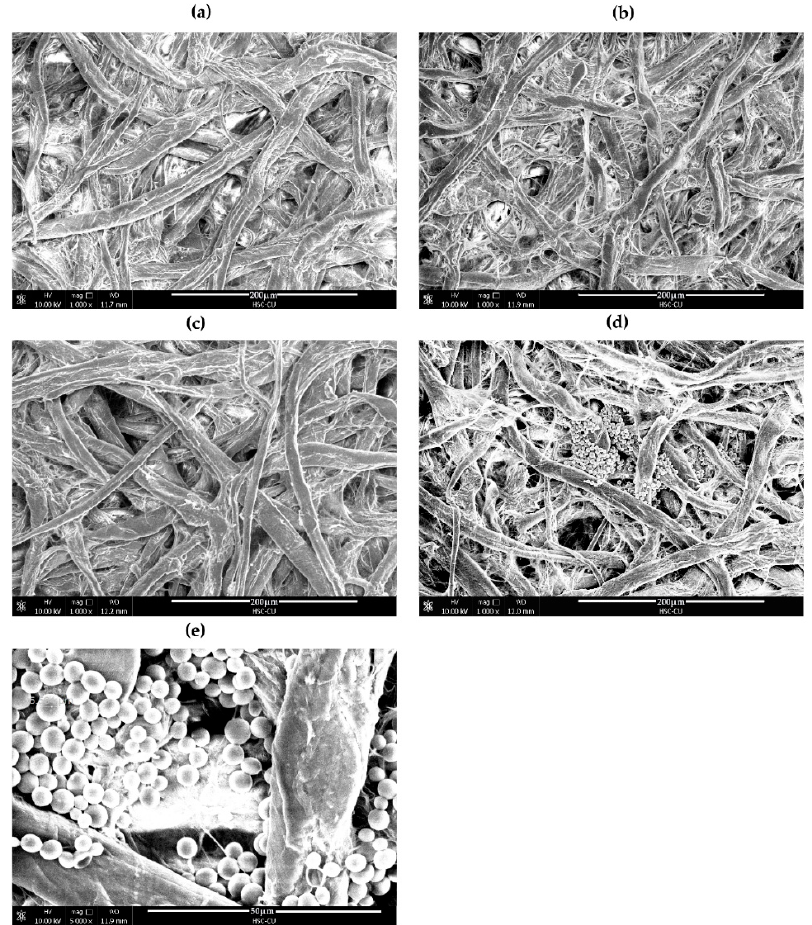
Figure 2. ( a ) Bare Whatman grade 1004; ( b ) polyethyleneimine (PEI) immobilized on Whatman filter; ( c ) CA immobilized on Whatman filter; ( d ) PEI–CA complex on Whatman filter (1000×); ( e ) PEI–CA complex on Whatman filter (5000×).